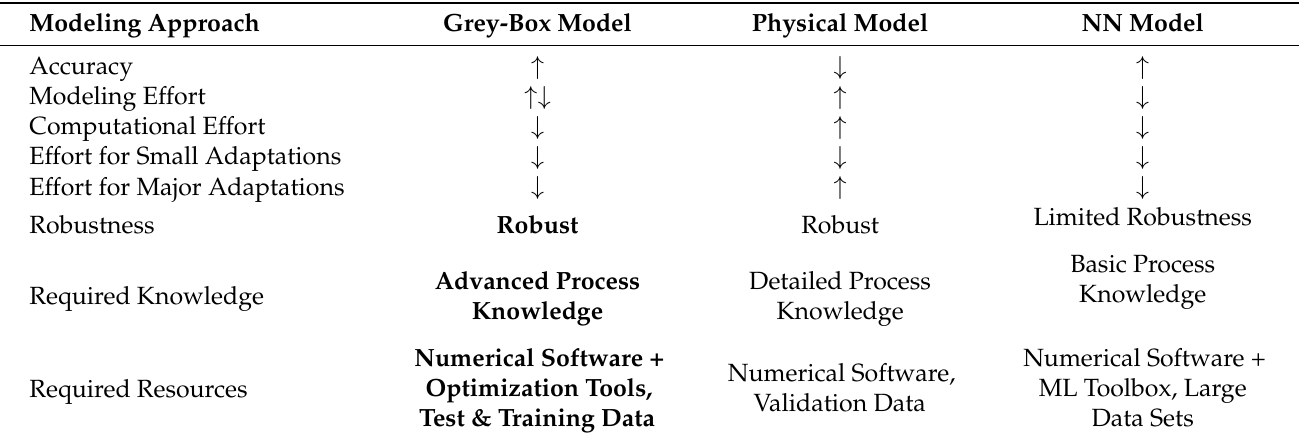
Table 3. Summary of the comparison–grey-box model vs. physical model vs. data-driven NN model. Modeling